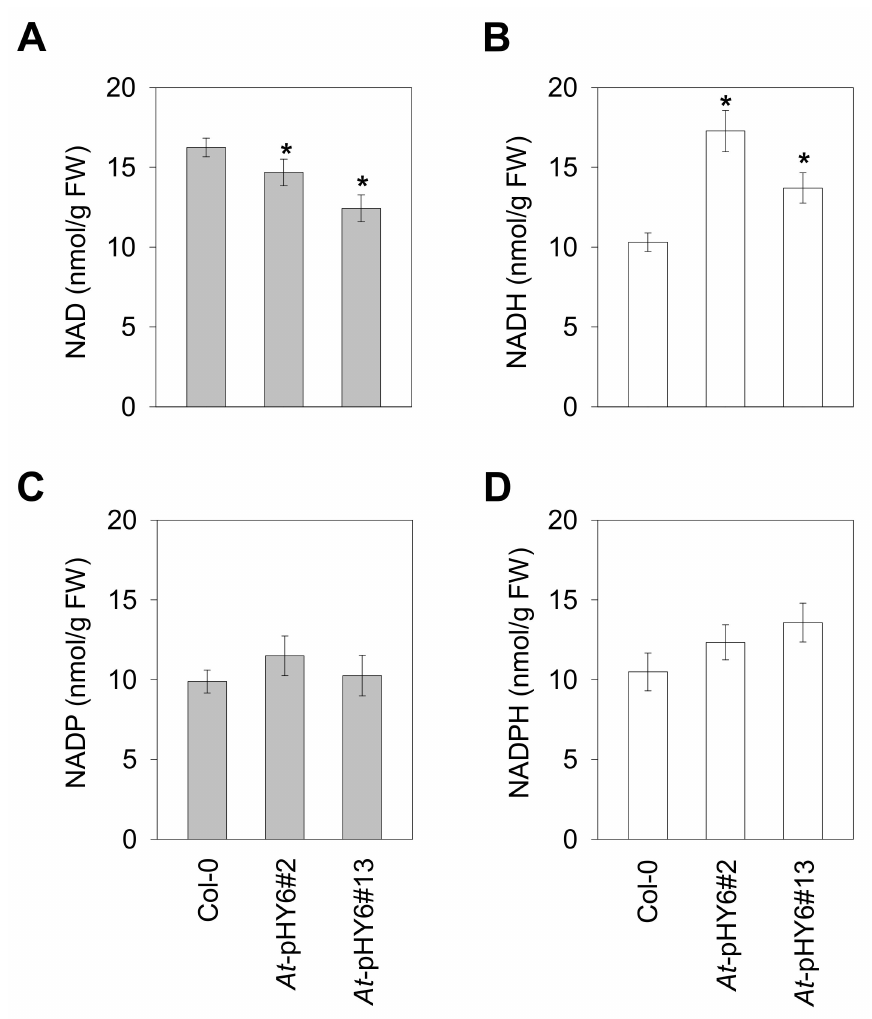
Figure 4. Contents of pyridine nucleotides in Col-0 and RNAi plants upon Pst-avrRpt2 infection. Levels of NAD ( A ), NADH ( B ), NADP ( C ) and NADPH ( D ) in bacterium-challenged plants at 48 hpi were determined. Data are means ± SE of four independent extracts. Asterisk indicates significant differences from Col-0. * p <